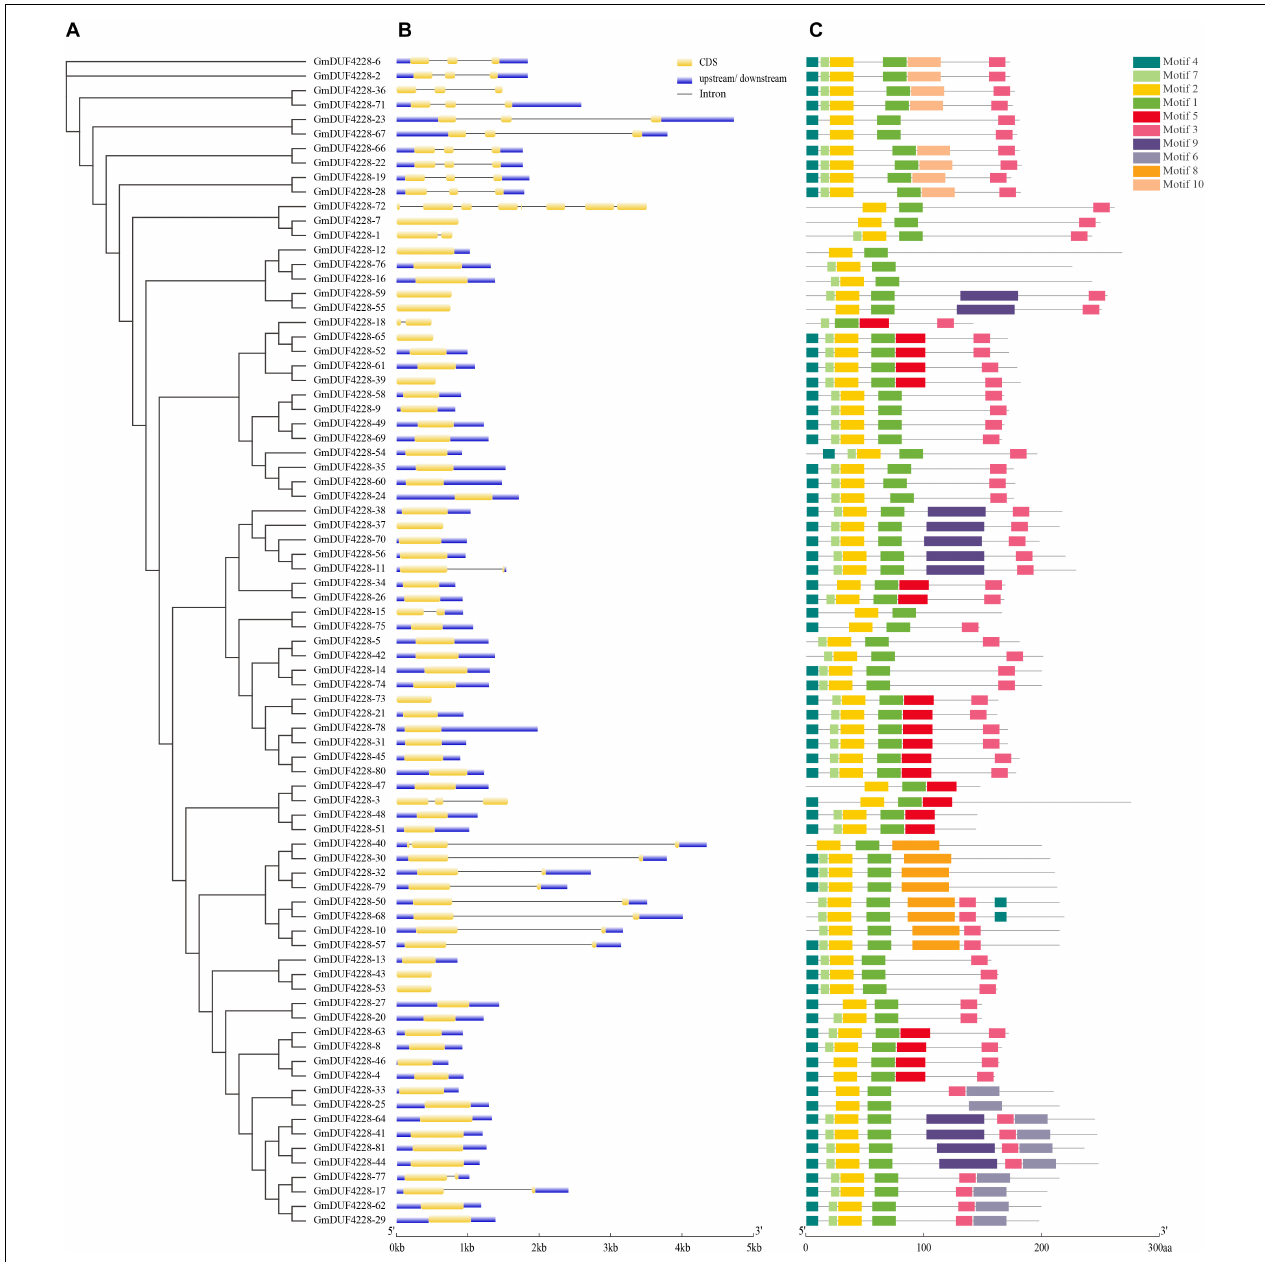
FIGURE 3 | Phylogenetic relationships, gene structures, and conserved motifs of GmDUF4228. (A) Phylogenetic tree of DUF4228 proteins from soybean constructed using the ML method. (B) Exon/intron organization of GmDUF4228 genes. Yellow boxes represent exons and black lines represent introns. The upstream/downstream regions of GmDUF4228 genes are indicated by blue boxes. The scale at the bottom is used to infer the lengthes of exons. (C) Distribution of conserved motifs in GmDUF4228 genes. Ten putative motifs are indicated by colored boxes ( Table 2 ).